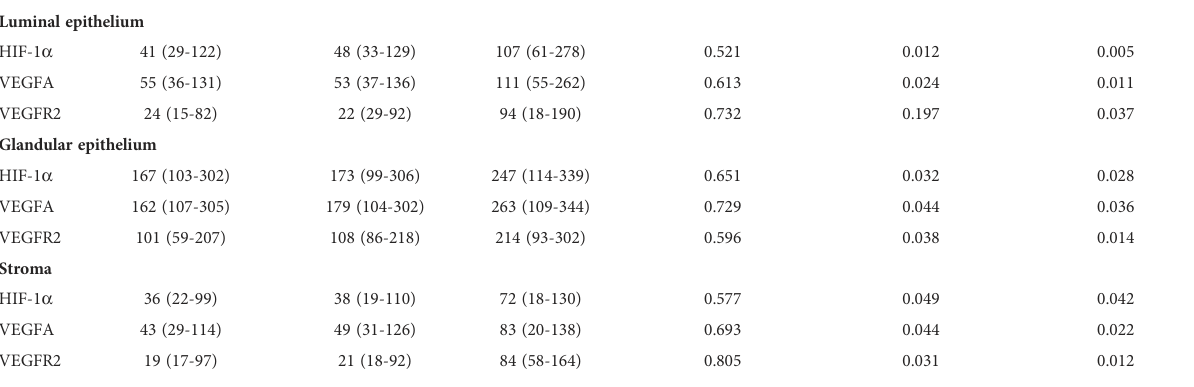
Data are expressed as median (range). Groups were compared by non-parametric Kruskal-Wallis test with Dunn ’ s multiple comparisons test.